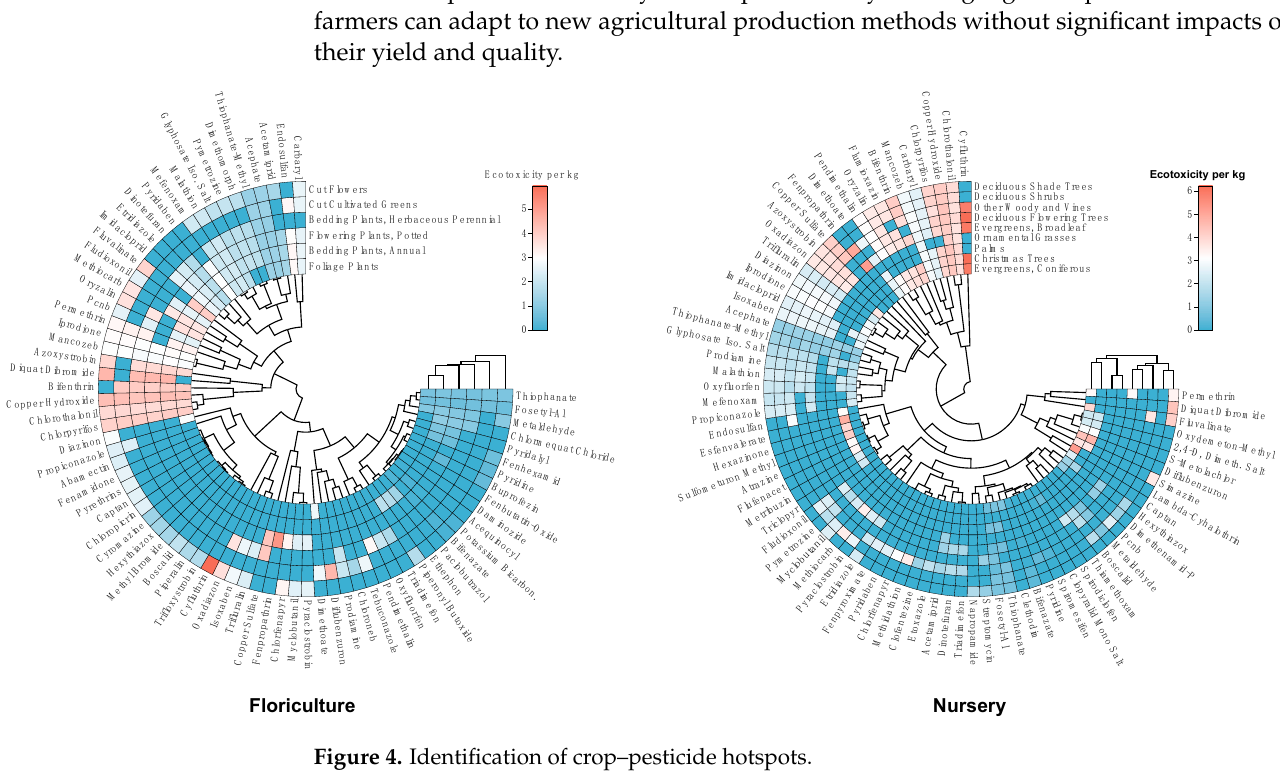
Figure 4. Identi fi cation of crop–pesticide hotspots. Figure 4. Identification of crop–pesticide hotspots.